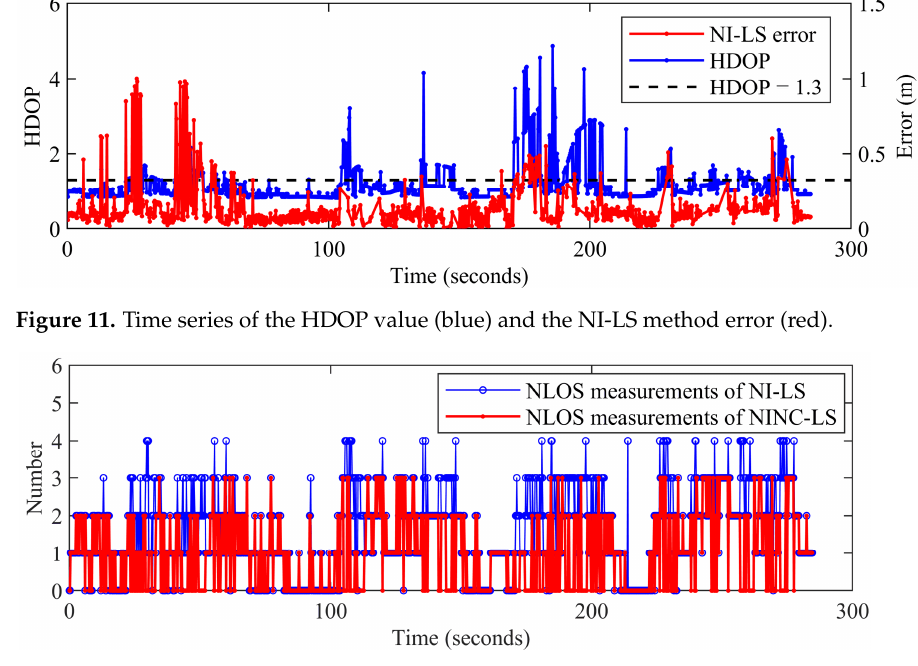
Figure 13. Trajectories of the eight methods: NINC-LS (yellow), LeGO-LOAM (green), REKF (grey), NI-REKF (cyan), NINC-REKF (magenta), FGO (orange), NI-FGO (blue) and NINC-FGO (red).